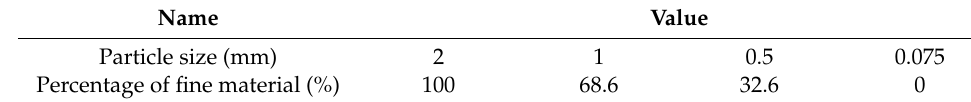
Figure 2. Grading curves. Table 1. The particle gradation of standard sand.